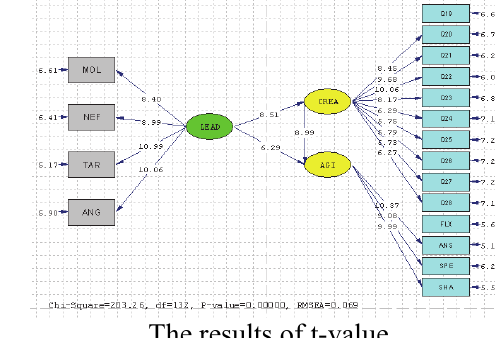
Fig. 2. The summary of the implementation of structural equation